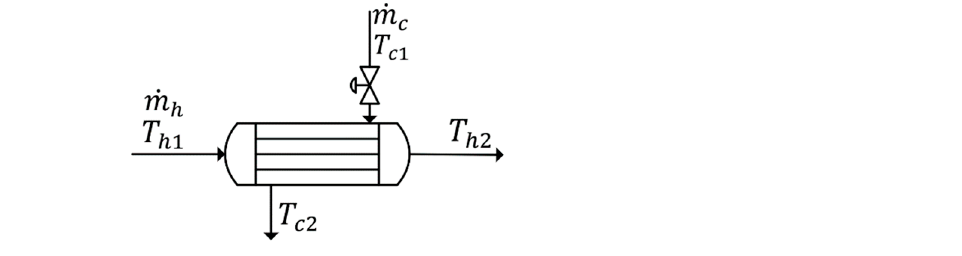
Figure 1. Simplified scheme of a cooler, where manipulation of the cold utility flow is allowed.